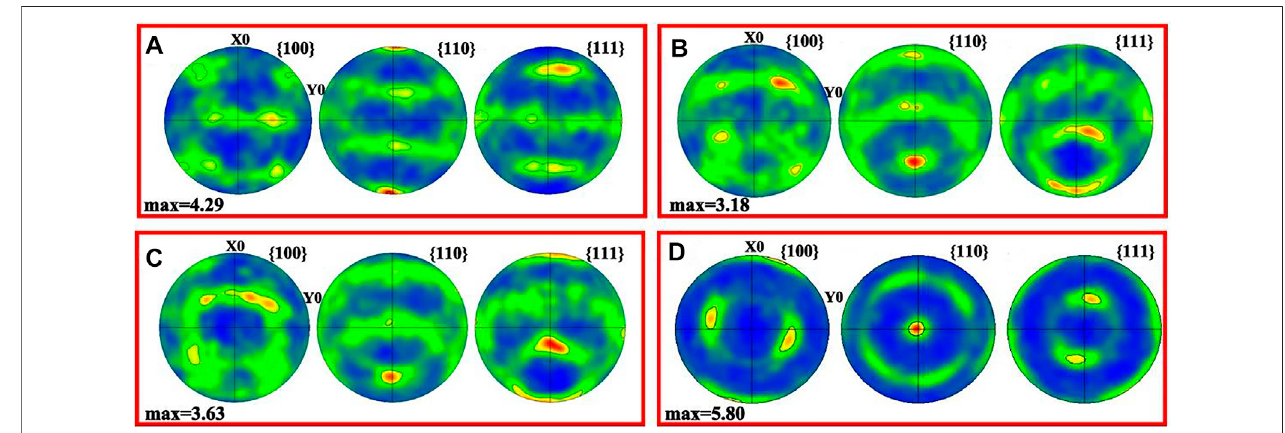
FIGURE 5 | PF of SLM-processed 316L SS from different angles relative to the build substrate: (A – D) angle of 0, 45, 60, and 90.